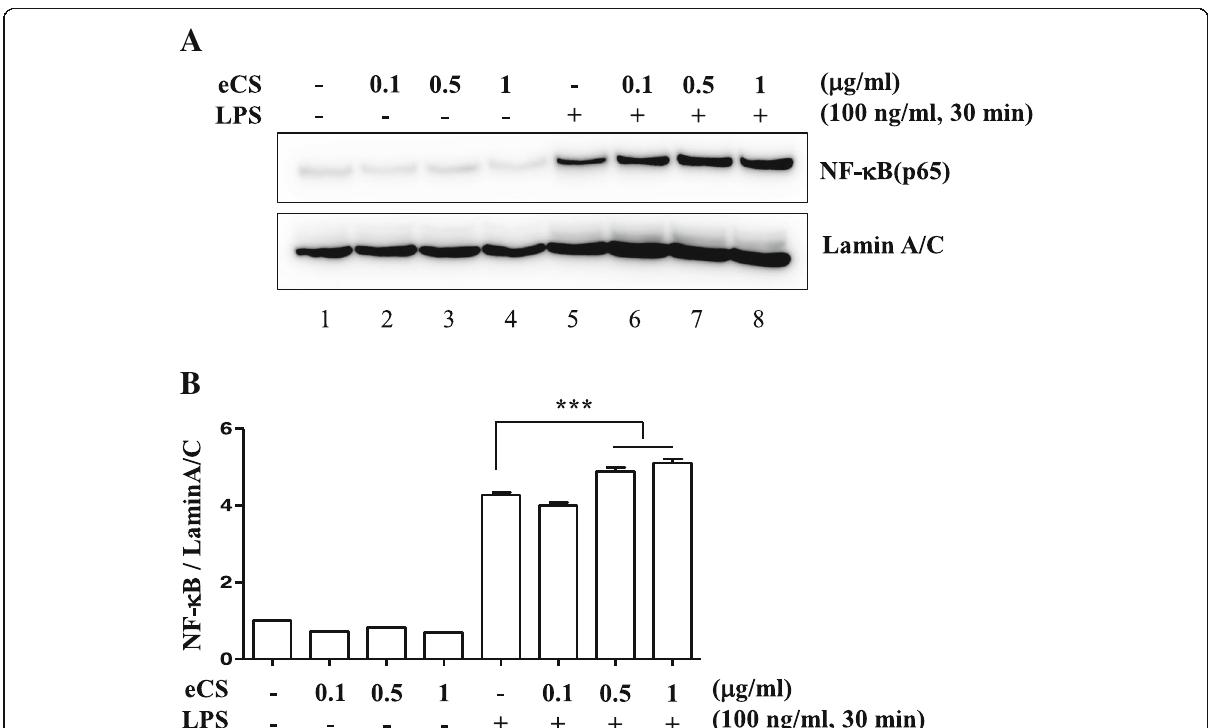
Fig. 3 The effect of eCS on NF- κ B activity. a Pre-treated with eCS for 16 h, RAW 264.7 cells were further treated with TLR4 specific LPS (100 ng/ml) for 30min. Nuclear proteins were fractionated and analyzed by immunoblotting for p65 RelA, a key subunit of NF- κ B. The membrane was stripped and blotted for Lamin A/C as for an internal control for nuclear proteins. Each band on the blots was analyzed by ImageJ, a densitometric analysis program ( b ). The relative levels of nuclear p65 RelA were calculated over Lamin A/C. *** P was less than 0.0001, compared to the LPS-treated control. Data are presented as the mean±SEM of 3 measurements. At least, two more similar experiments were performed independently and a representative result is